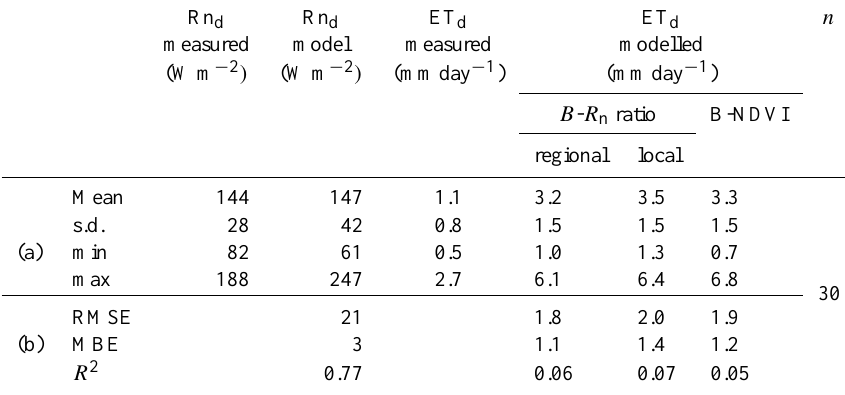
Table 2. (a): Descriptive statistics of daily net radiation (Rn d ) and daily evapotranspiration (ET d ) measured over the Scots pine stand, and TERRA MODIS Rn and ET d modelled using 3 methods B - R n ratio regional, B - R n ratio local and B-NDVI (see text). (b) Model